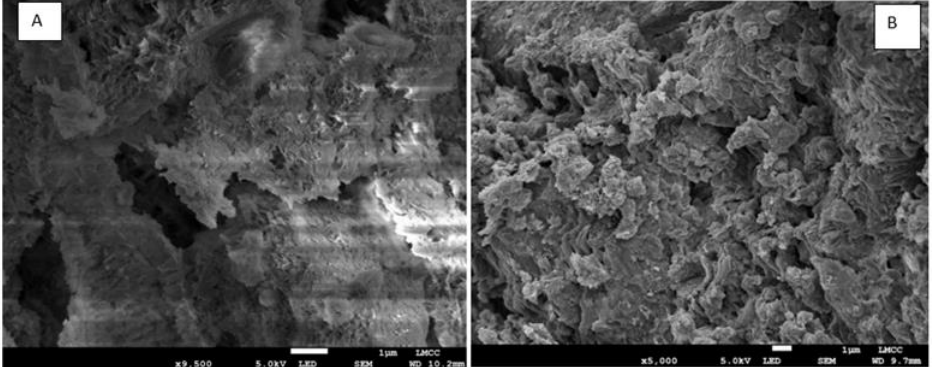
Figure 15. SEM of ( A ) uncarbonated and ( B ) carbonated samples. Carbonation took place at 2 bar for 24 h following 120 h of curing.